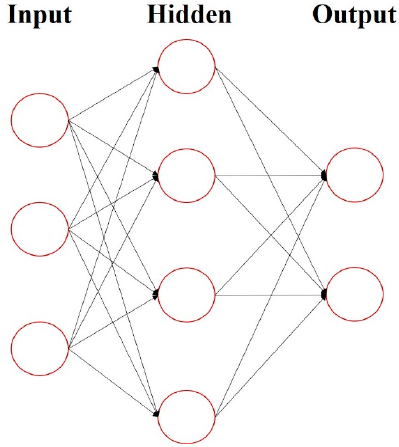
Figure 4. Artificial neural network (ANN).